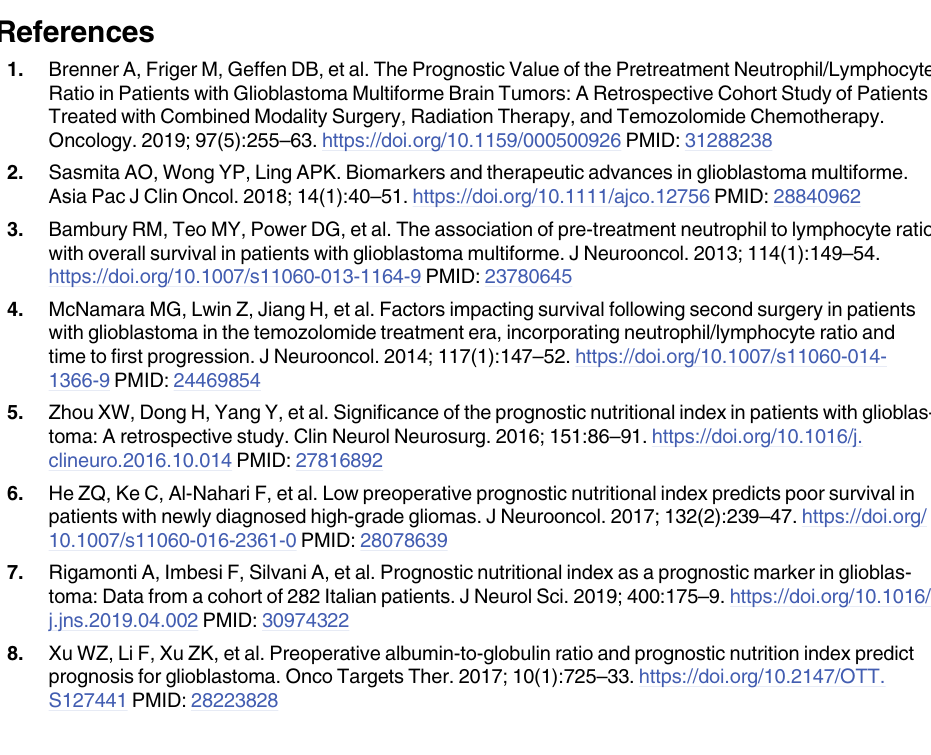
S1 Table. Univariate and multivariate analysis for PFS and